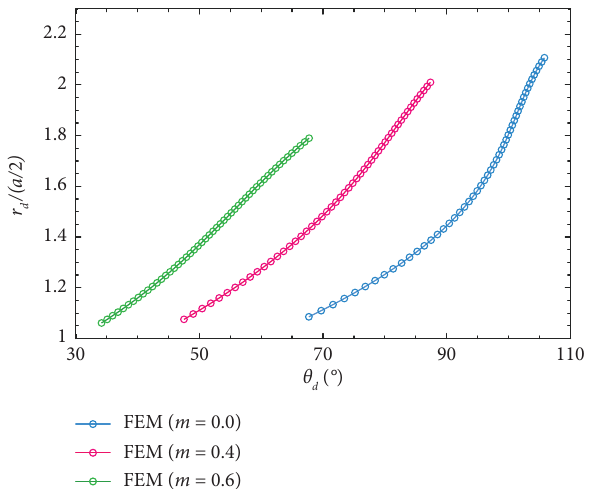
Figure 16: Final normalized breakout depth versus breakout